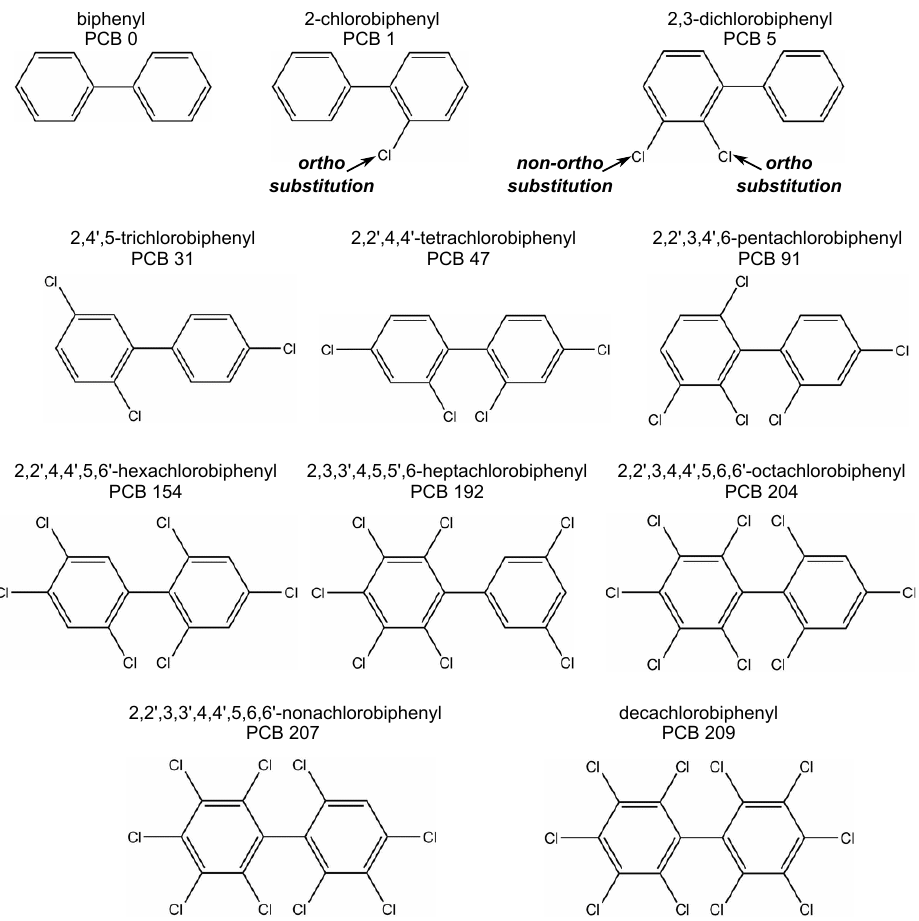
Figure 1. Two-dimensional structural diagrams of the PCBs included in the experiments. Non- ortho and ortho substitutions are indicated for the monochloro and dichloro